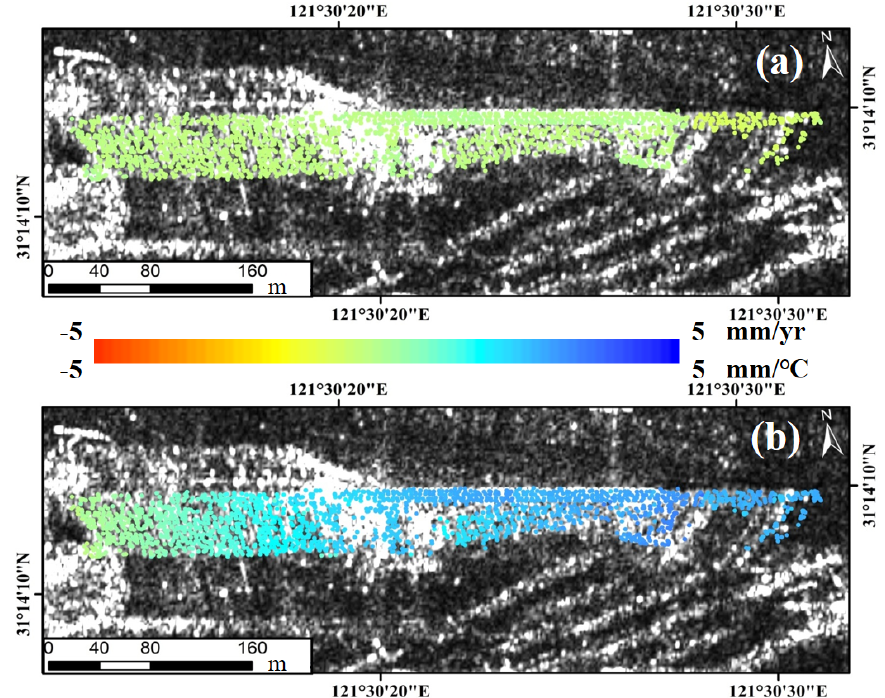
Figure 7. The ( a ) trend deformation and ( b ) thermal dilation of the SWFC.